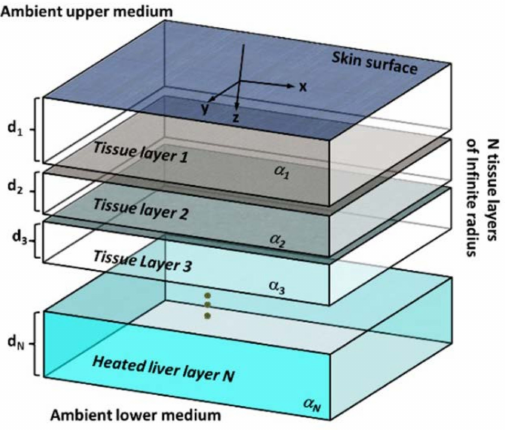
Figure 2. Analytical multi-layered thermal diffusion model